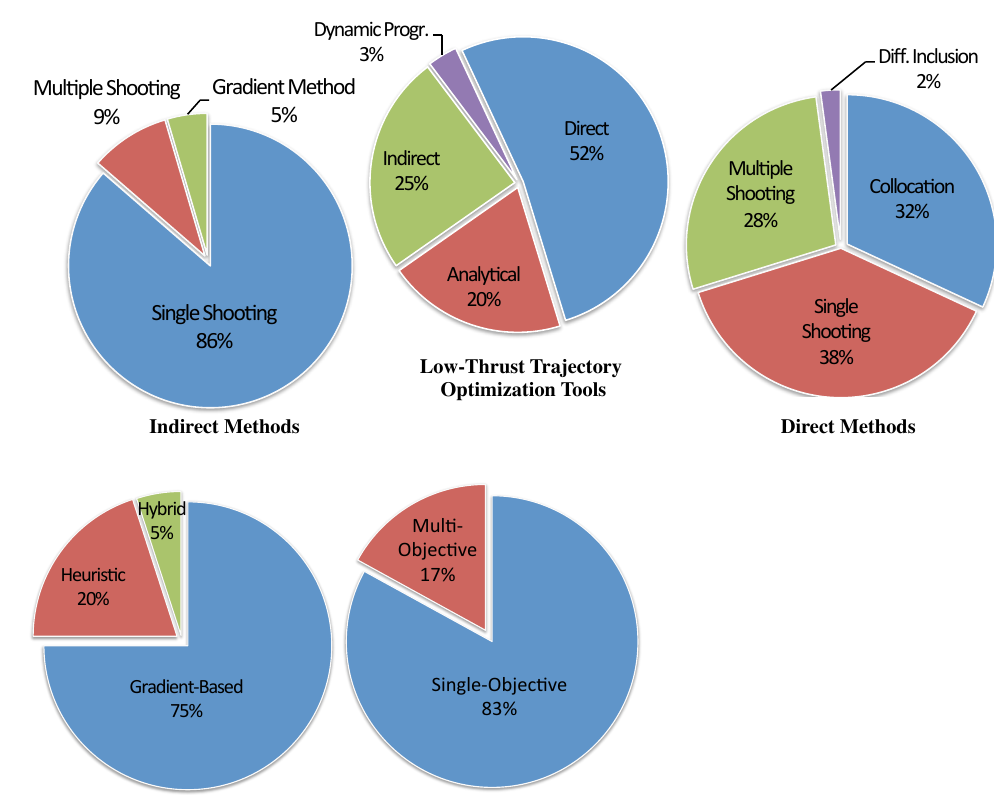
Figure 9. Overview of investigated Low-Thrust Optimization